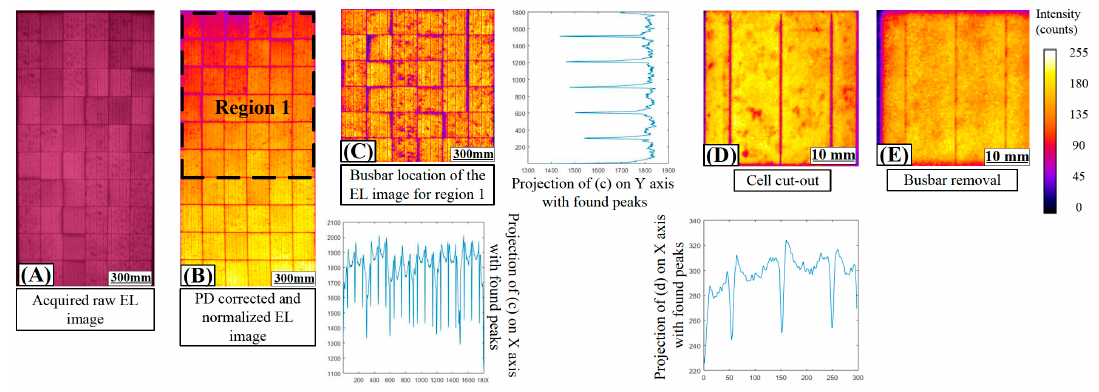
Figure 2. The image processing procedure used in this study: ( A ) acquired raw EL measurements; ( B ) the prospectively corrected normalized image; ( C ) busbar identification; ( D ) solar cell extraction; and ( E ) busbar removal.